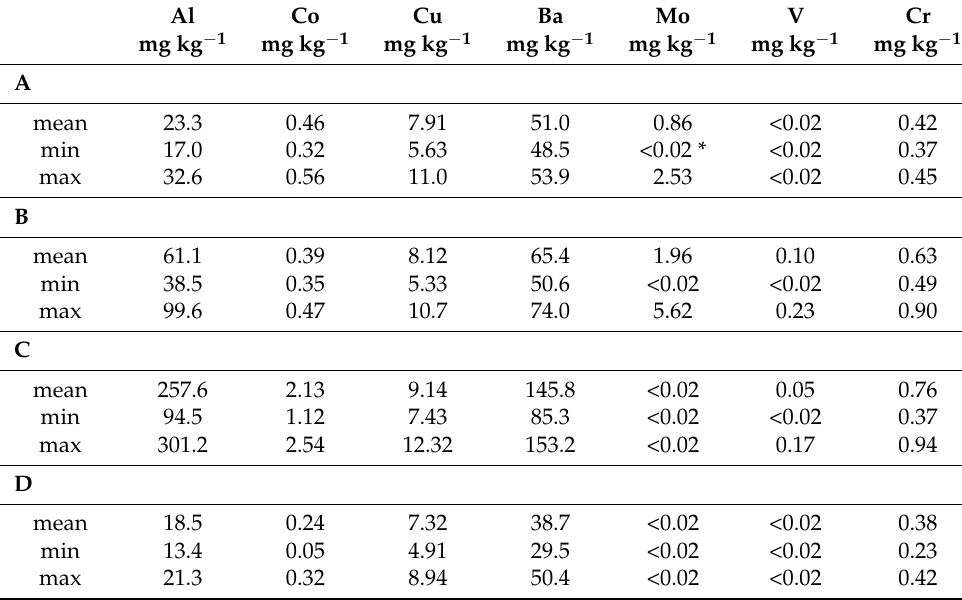
Table 3. The content (mg/kg) of non-essential elements in dry samples.